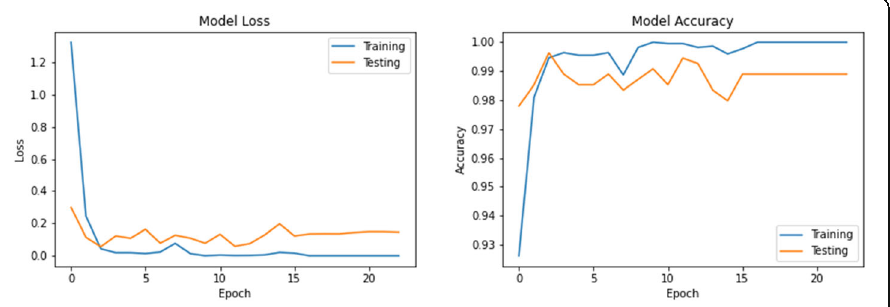
Fig. 12 InceptionV3 accuracy loss